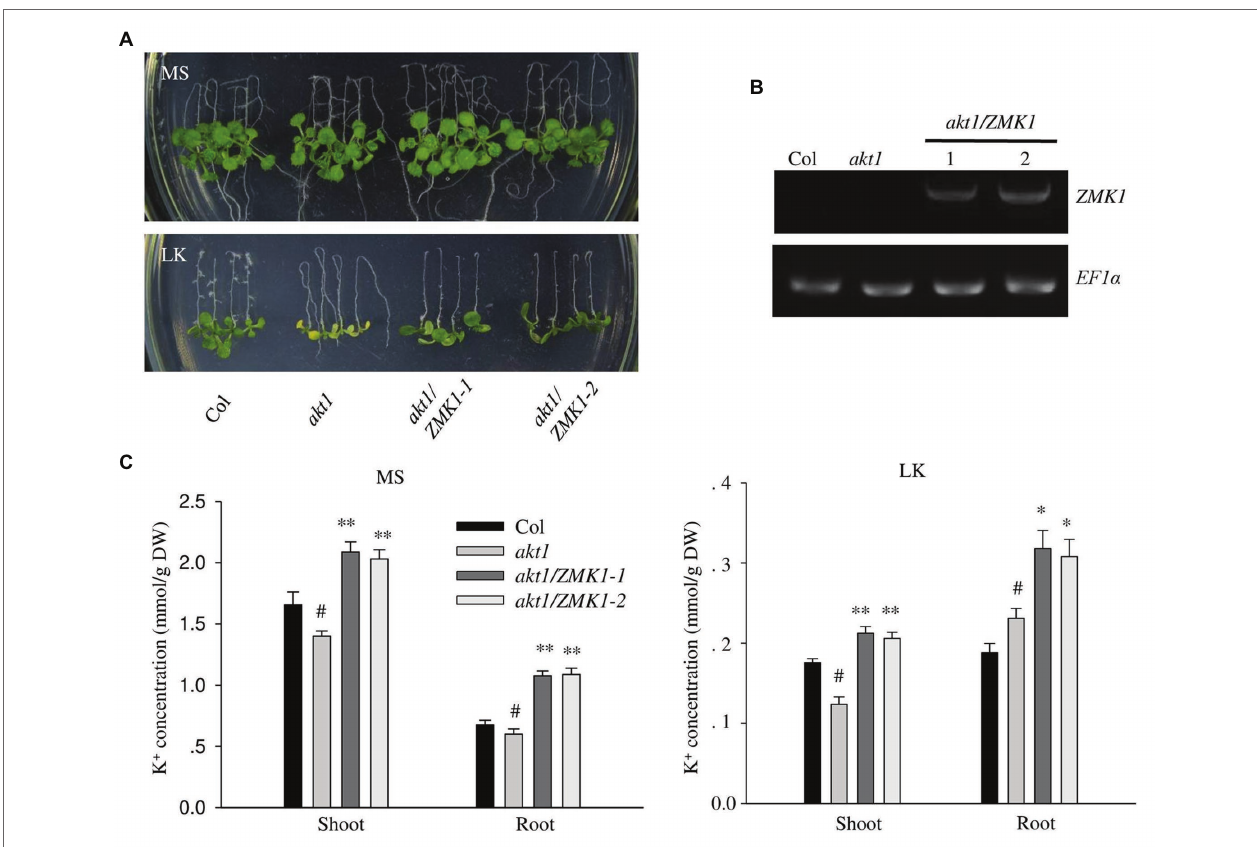
FIGURE 2 | Complementation of Arabidopsis akt1 mutant by ZMK1. (A) Plant materials grown on Murashige and Skoog (MS) medium for 4 days were transferred to MS or LK medium for another 7 days. (B) Detection of ZMK1 expression in different plant materials by reverse transcription PCR (RT-PCR). EF1a was used as a quantitative control. (C) Quantification of K + concentration in root and shoot parts of different plant materials after grown on MS and LK medium for 7 days. The data are presented as means ± SE ( n ≥ 3), Student’s t -test ( ∗ p < 0.05, ∗∗ p < 0.01) was used to analyze statistical significance and “ # ” represents the